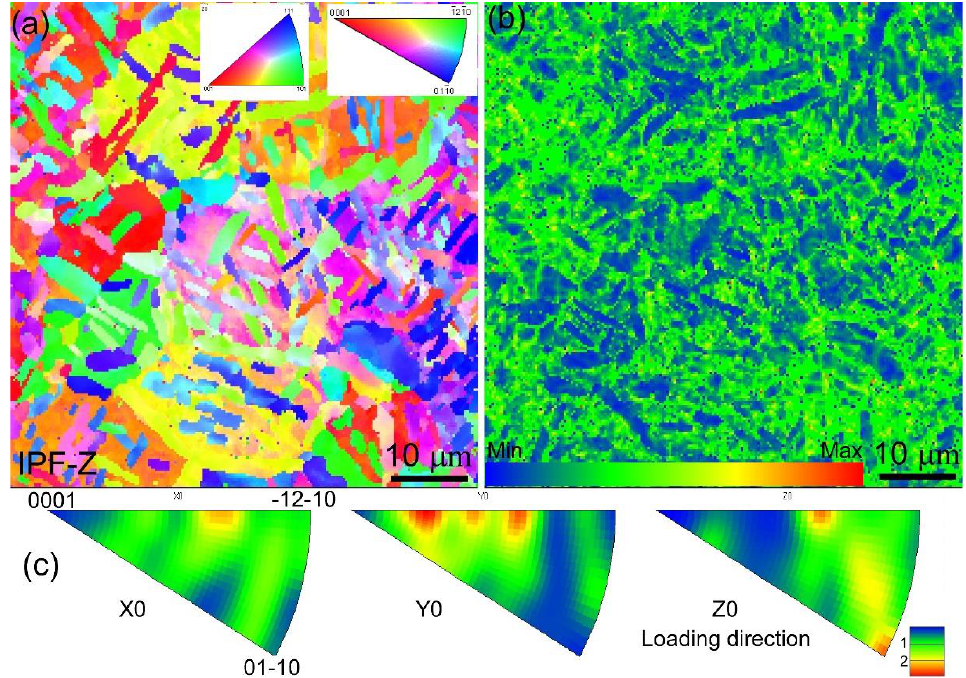
Figure 9. ( a ) EBSD orientation maps collected at AOI, ( b ) and ( c ) are the corresponding KAM map and IPF, respectively.